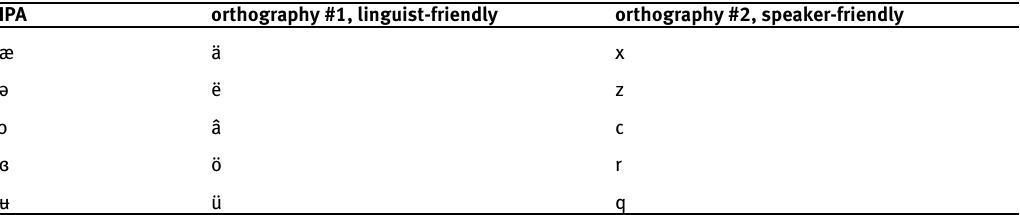
Table 2. Natqgu Vowel